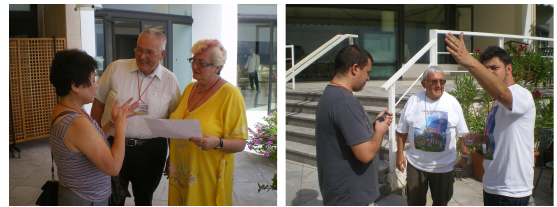
Figure 4: Sometimes, the discussion among partici- pants was quite lively